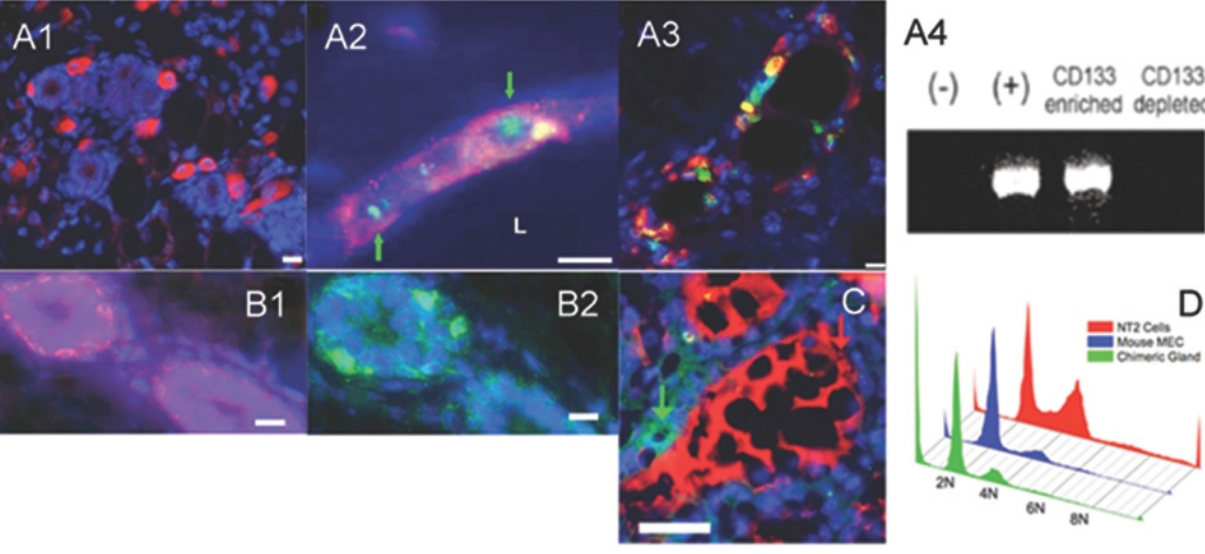
Figure 3. Human cancer cells identified in the tumor-free chimeric mammary outgrowths are hormonal responsive, secrete human milk proteins in the mammary ducts and do not show increased ploidy. (A1) Human-specific immunocytochemical staining for CD133 (red) shows CD133-positive NT2 cells present within the confines of the fat pad containing regenerated mammary ducts. (A2) Human-specific fluorescent in situ hybridization (green, nuclear; identified with green arrows) and human-specific immunocytochemical staining for CD133 (red) shows NT2 cells present within the mammary outgrowths. (A3) CD133-positive NT2 cells (red) differentiate into ER-alpha (green) luminal epithelial cells. (A4) PCR shows human specific Y-chromosome present in NT2 cells prior to transplantation (+) as well as in the CD133 enriched fraction obtained by magnetic sorting but not in normal mouse mammary epithelial cells (-) and the CD133 depleted fraction. (B1-B2) Basal cells express human K14 (red) and mouse K14 (green) in consecutive sections of the same chimeric duct. (C) Immunocytochemical staining of chimeric mammary outgrowth for human alpha lactalbumin (green) and mouse caseins (red). (D) Flow cytometry of propidium iodide stained cells demonstrate that chimeric glands (green) do not contain a greater proportion of cells with abnormal ploidy as compared to cultures of mouse mammary epithelial cells (blue) or NT2 (red). All sections are counterstained with DAPI (blue). Scale bars (A1) 20  m, (A2) and (A3) 15  m, (B1) and (B2) 10  m, and (C) 25